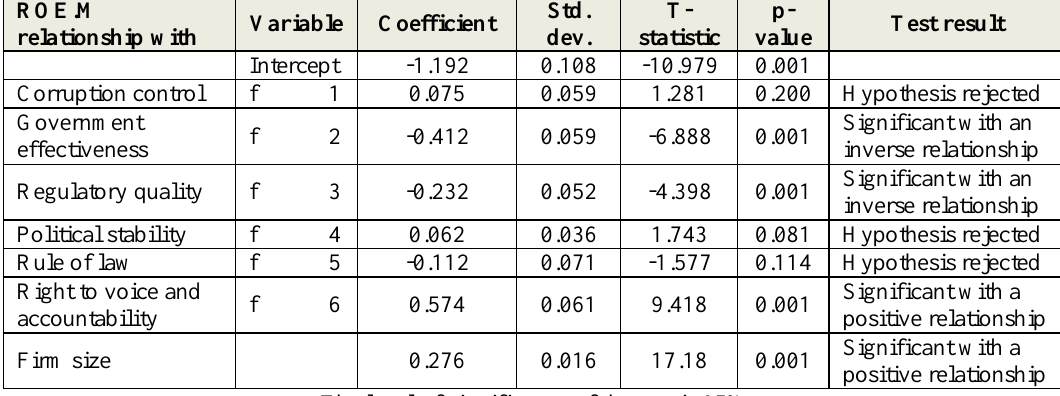
Table 9 . ROE.M relationship with governance